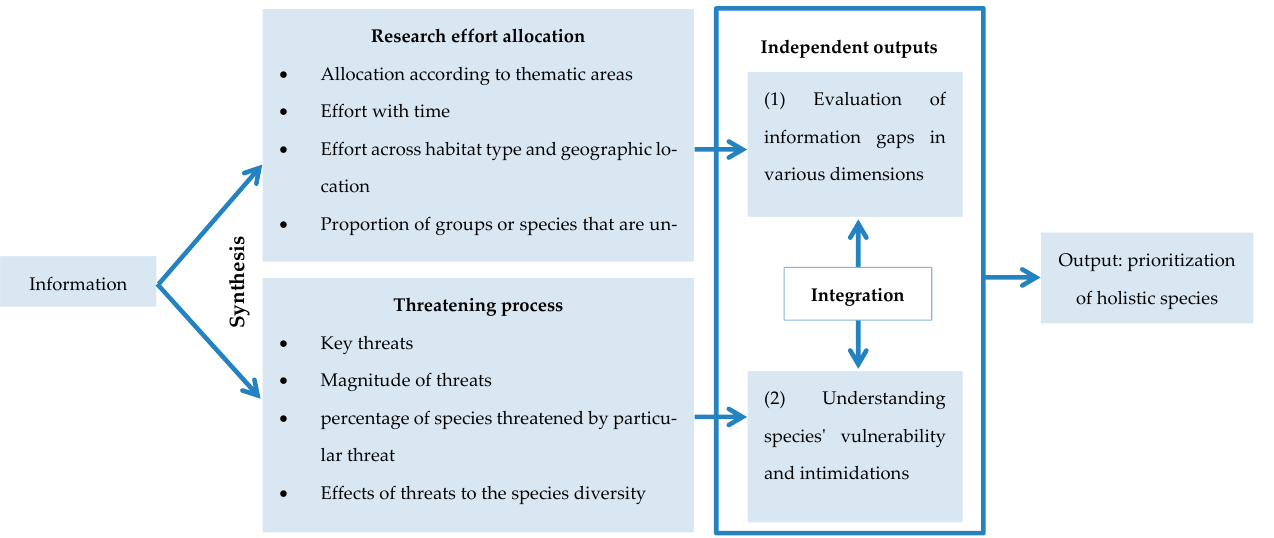
Figure 6. A proposed framework of leading information about one species to a holistic conservation of freshwater ecosystems (modified from Tanalgo and Hughes [97]).